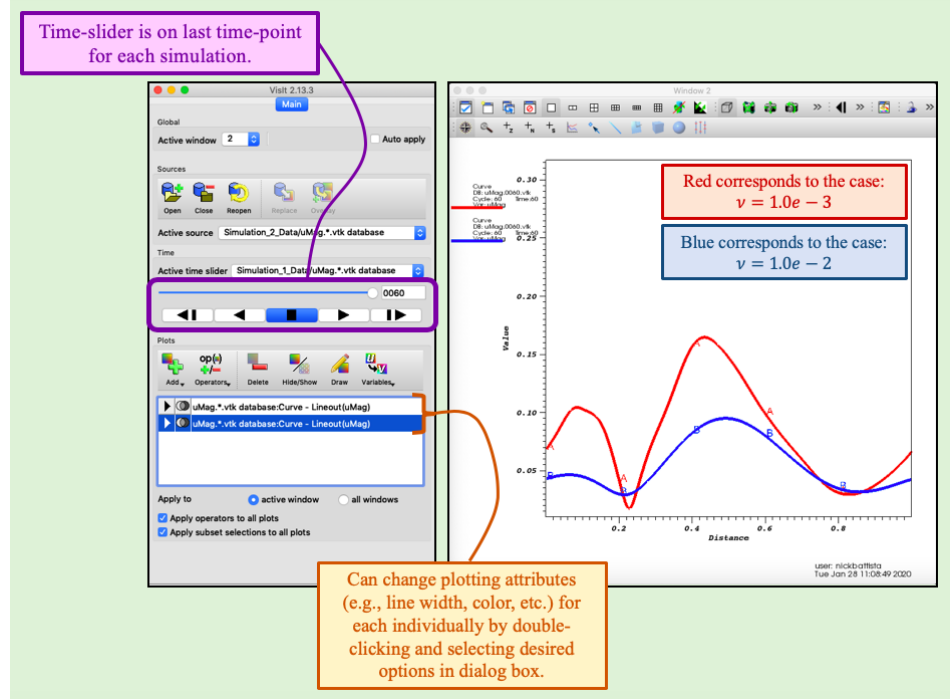
Figure 19. Comparing the measured magnitude of velocity data between both simulations at the last time-point data